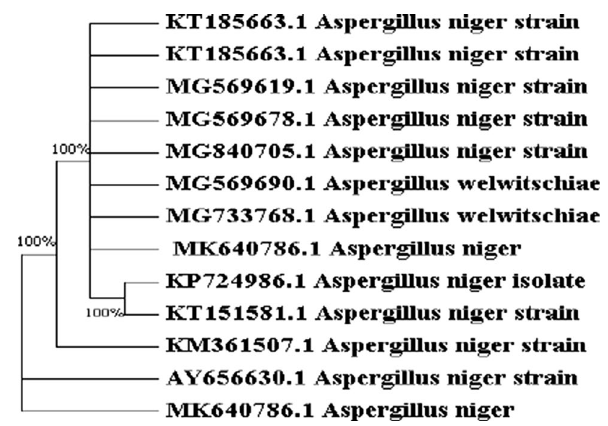
Fig. 2 Phylogenetic tree of Aspergillusniger (MK640786) constructed with neighbor joining method using MEGA 7